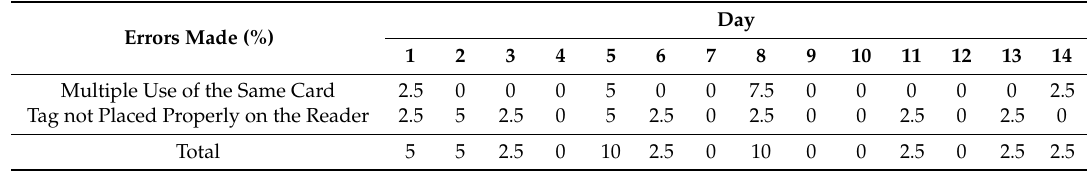
Table 2. The usage errors during the trial